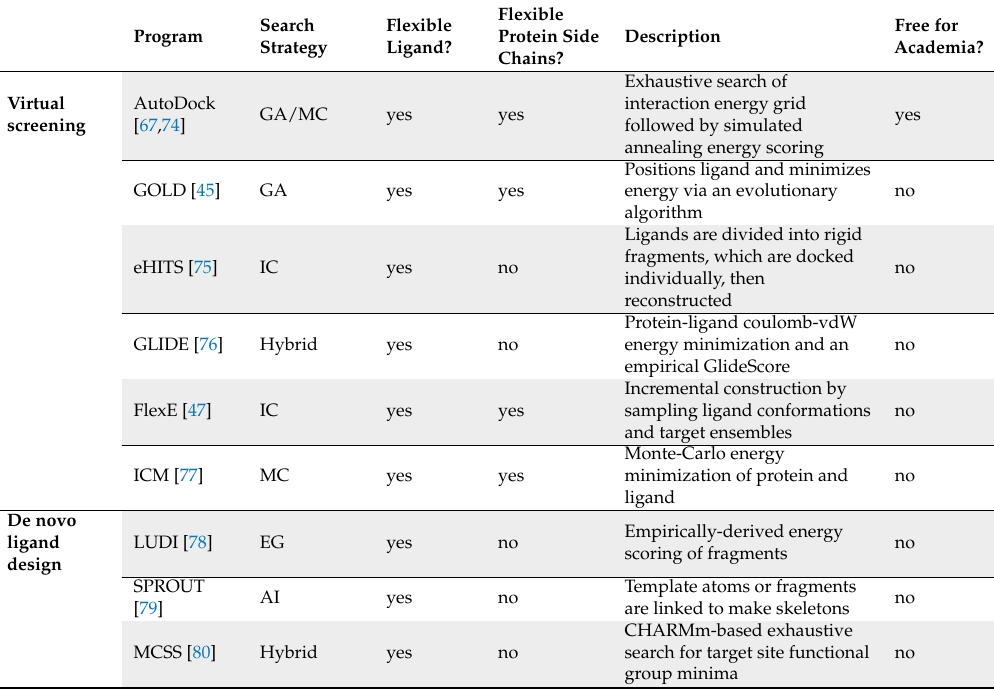
Table 1. A comparison of widely used SBDD computer